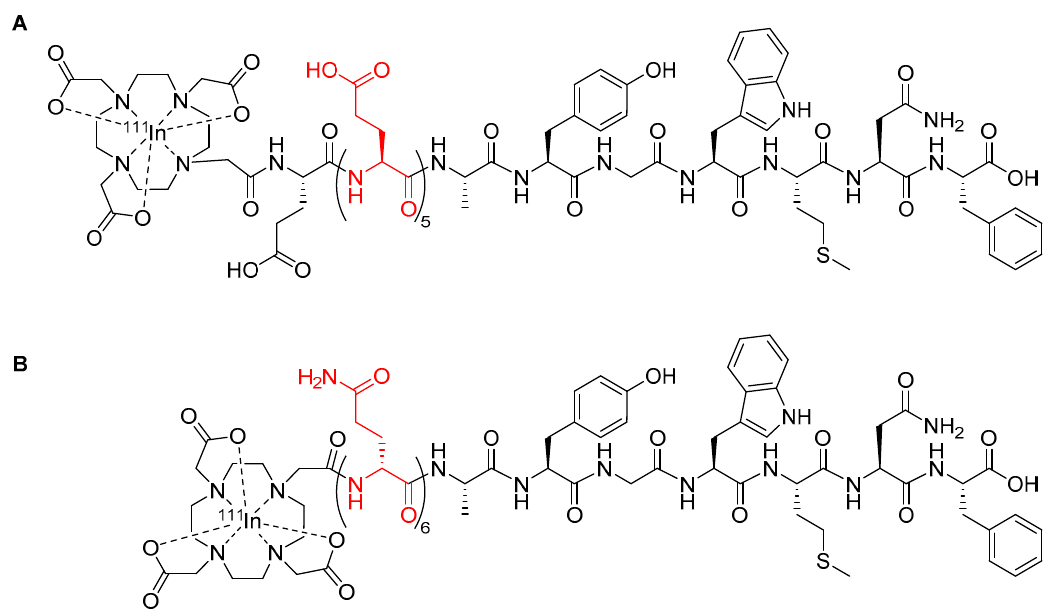
Figure 8. ( A ) Minigastrin analogue [ 111 In-DOTA]MG0 with the five L -glutamic acids linker highlighted in red [67]; ( B ) minigastrin peptide radiopharmaceutical developed by Kolenic-Petial et al., with the six d -amino acids linker highlighted in red [68].